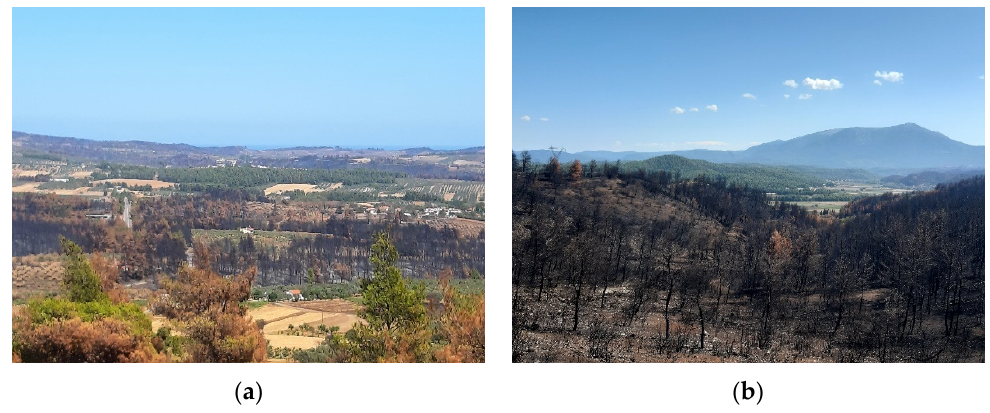
Figure 17. ( a ) Not burnt areas in the middle, forest without connection with the rest of the forest area (SaIs). ( b ) Burnt areas. In back, the flat land of Krya Vrisi which stopped the fire. The linear flatland of Krya Vrisi divides the island of Euboea and contributed to con ‐ taining the fire and restricting the evolution of the front of the fire (Figures 18 and 19).